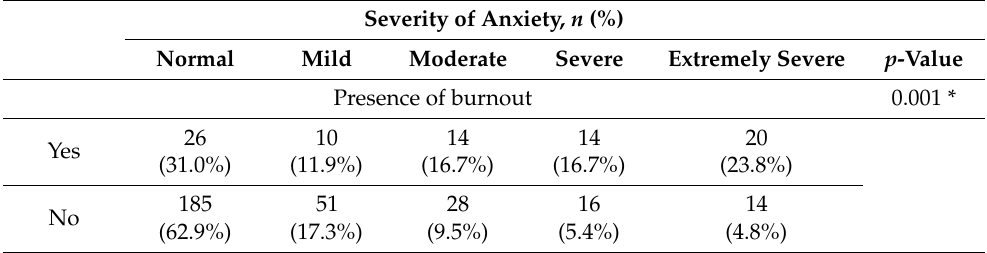
Table 4. The association between anxiety and burnout in clinical year medical undergraduate students in UKM during the COVID-19 pandemic. * p < 0.05 is considered as significant.